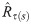
Selection for stable and fluctuating epidemics.Left graphs compare R^τ(s) estimates (blue with 95% confidence intervals) at the APE window length k* to those when k is set to its upper and lower limits. Right graphs give corresponding one-step-ahead predictions I^s given the window of data Iτ(s−1) (blue with 95% prediction intervals). Dashed lines are the true Rs numbers (left) and dots are the true Is counts (right). The panels examine (A) stable (constant) and (B) periodically varying changes in Rs.